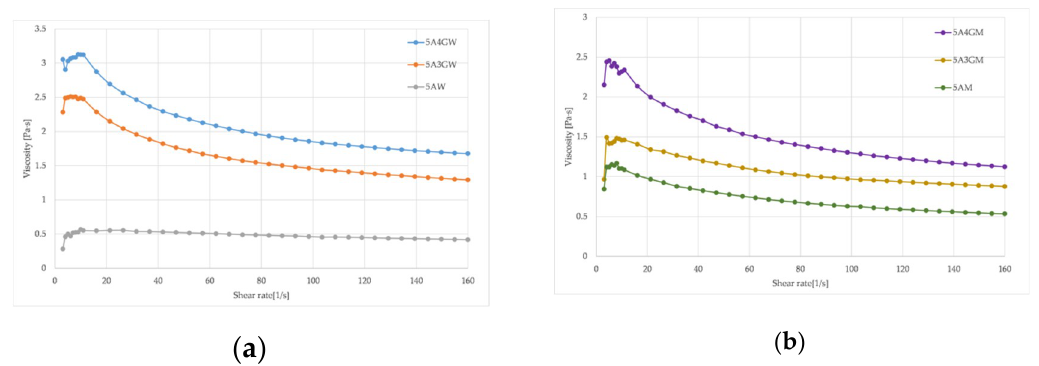
Figure 1. Rheological properties of the samples dissolved in water (W) ( a ) and full culture medium (M) ( b ) with different contents of gelatine.